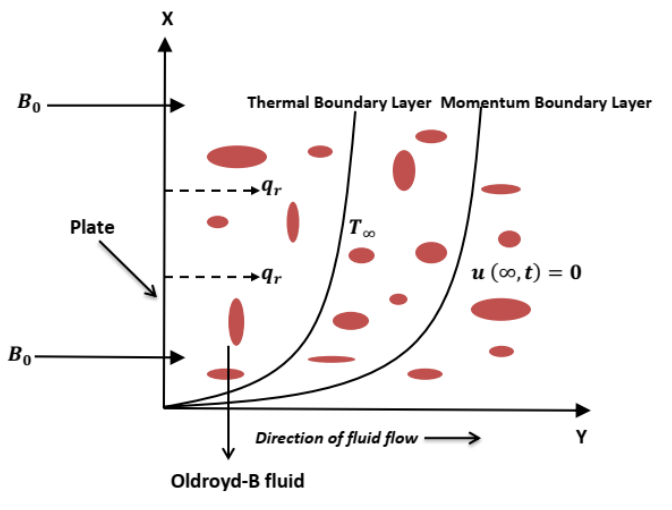
Figure 1. Geometrical presentation of